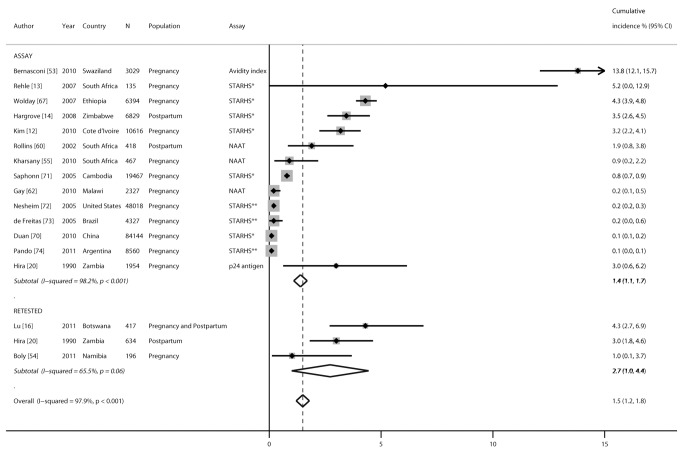
Forest plot of cumulative incidence of incident HIV infection during pregnancy and postpartum, by testing algorithm.The retested cumulative incidence category is calculated as the number of new infections per number at risk for studies, and the assay cumulative incidence category is calculated based on cross-sectional testing of HIV-positive samples using assay algorithms designed to detect incident infections; cumulative incidence expressed as percent for both retested and assay categories. NAAT, nucleic acid amplification test; STARHS*, STARHS using BED capture enzyme immunoassay; STARHS**, STARHS using bioMerieux Vironosticka less sensitive enzyme immunoassay.